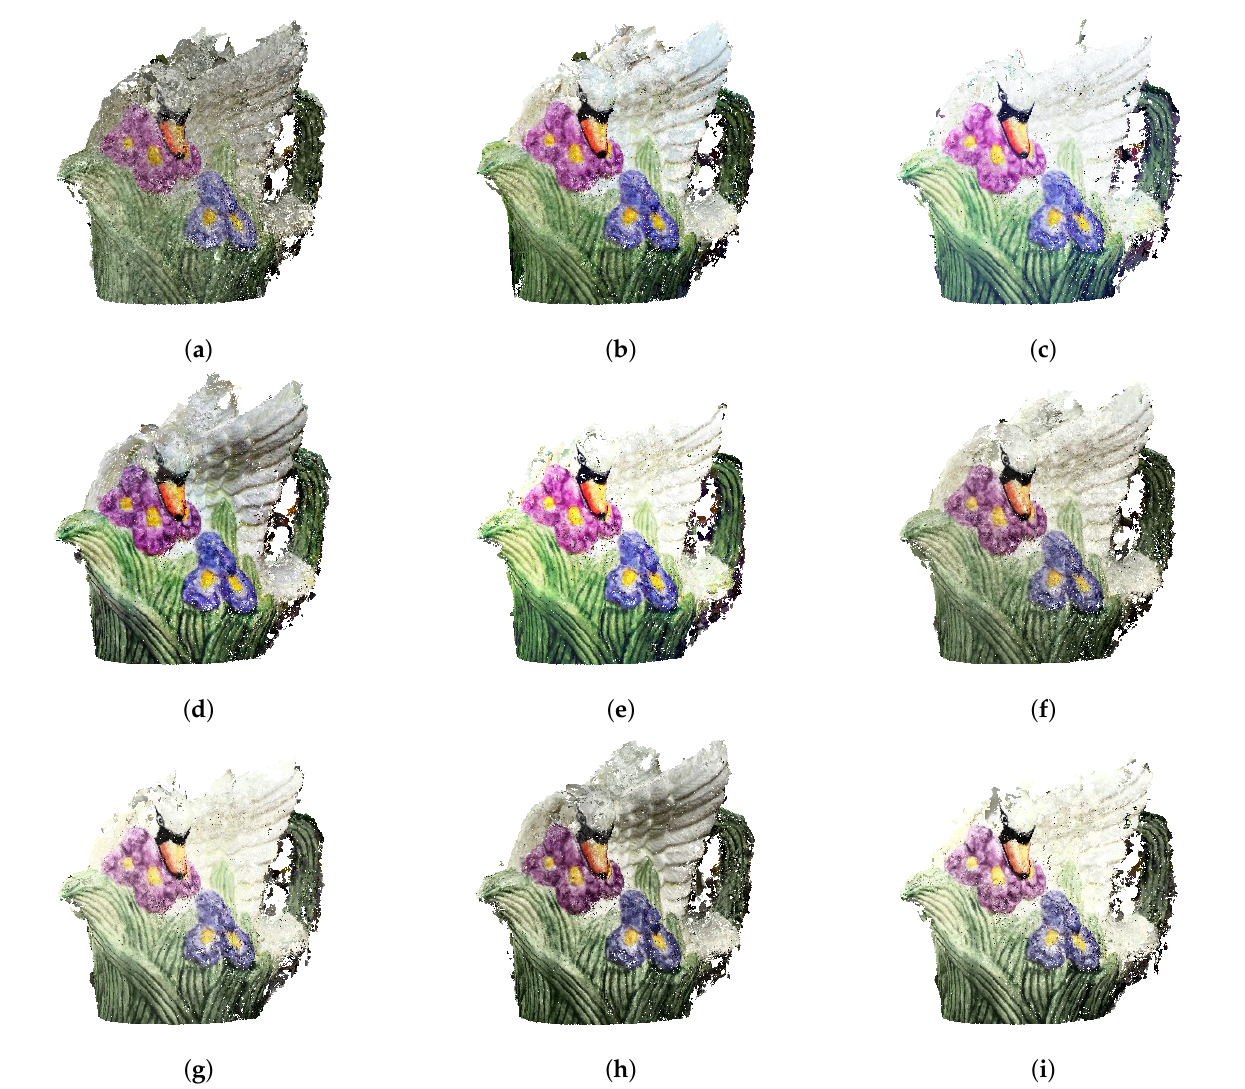
Figure 15. Dense point clouds of the porcelain figurine. Reconstructions based on photographs: ( a ) original; preprocessed in the RGB space with the use of: ( b ) histogram stretching, ( c ) histogram equalizing, ( d ) adaptive equalizing, ( e ) exact histogram matching; preprocessed in the L*a*b* space with the use of: ( f ) histogram stretching, ( g ) histogram equalizing, ( h ) adaptive equalizing, ( i ) exact histogram